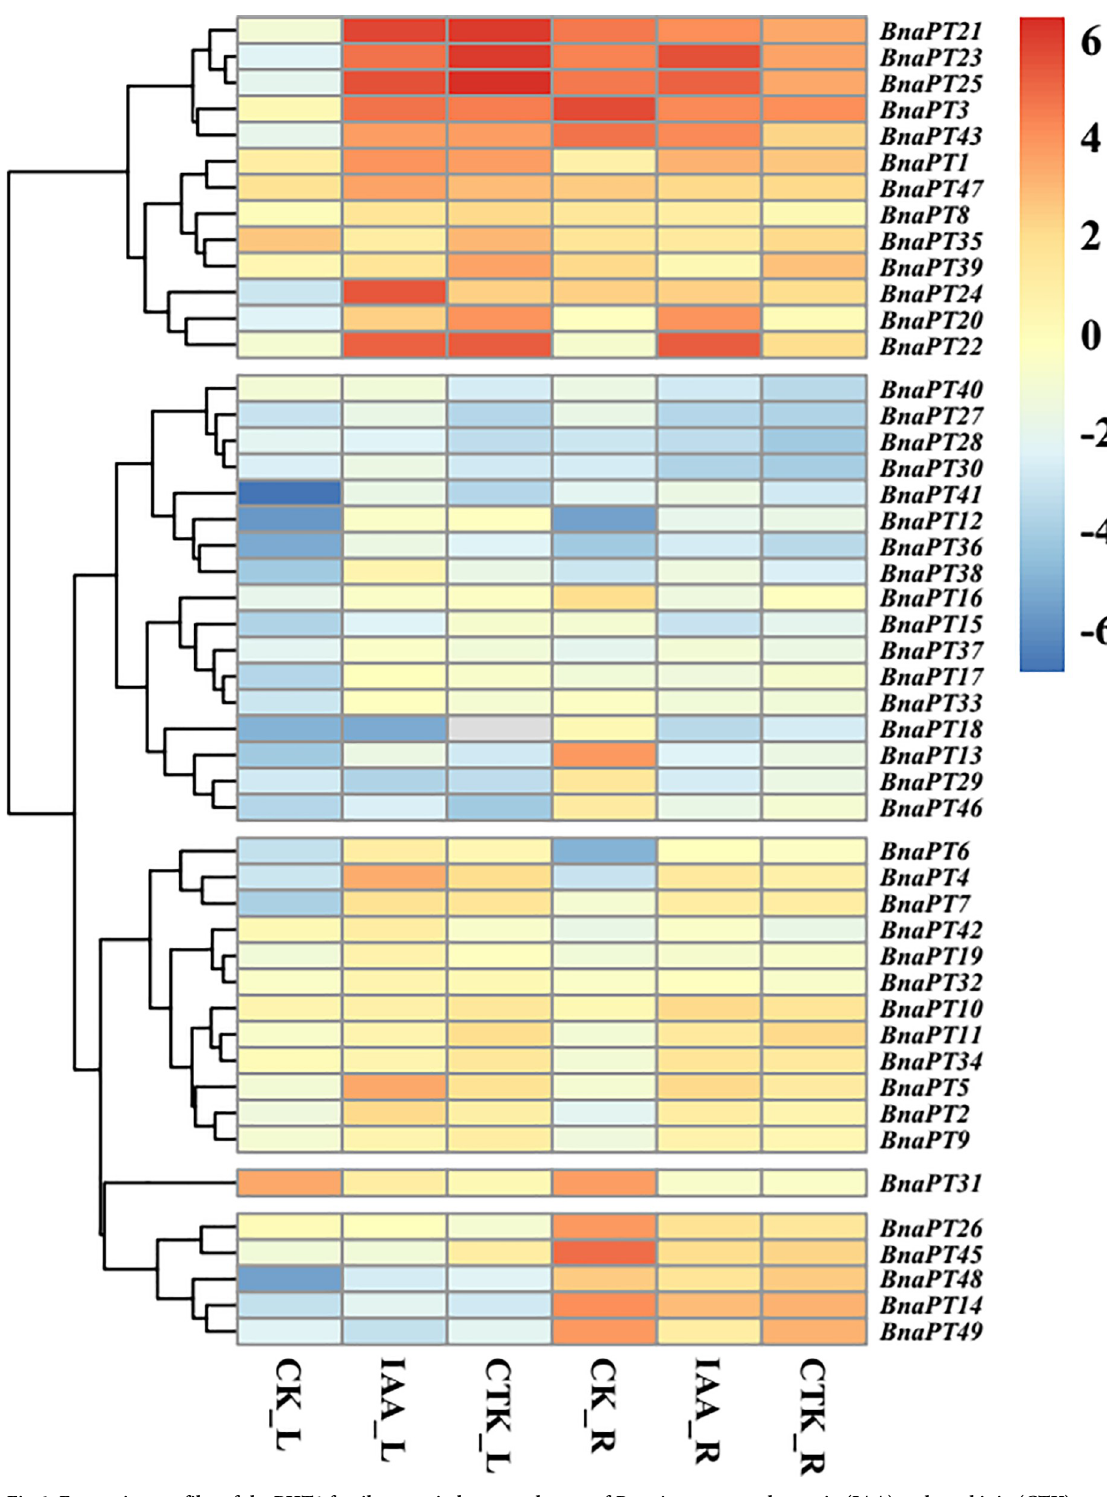
Fig 6. Expression profiles of the PHT1 family genes in leaves and roots of Brassica napus under auxin (IAA) and cytokinin (CTK) treatments. Seedlings of 14 days old were treated with Hoagland’s solution containing 100 μ M IAA and 100 μ M CTK for six days, respectively. The fully expanded leaf and roots were sampled separately for RNA extraction at harvest. L, leaf. R, roots. CK, full strength Hoagland’s solution. The color scale is shown on the right side. Gray box indicates data undetected. Heat map of gene expression profiles was generated using pheatmap package in R after data